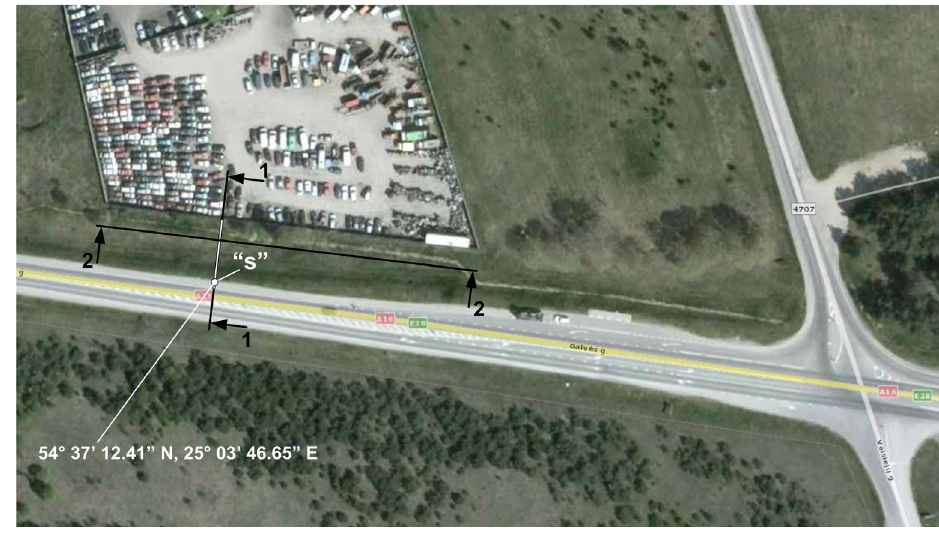
Figure 7. The view on the land strip between the route E28 and the target (the site of a used car store) (obtained with Google Earth